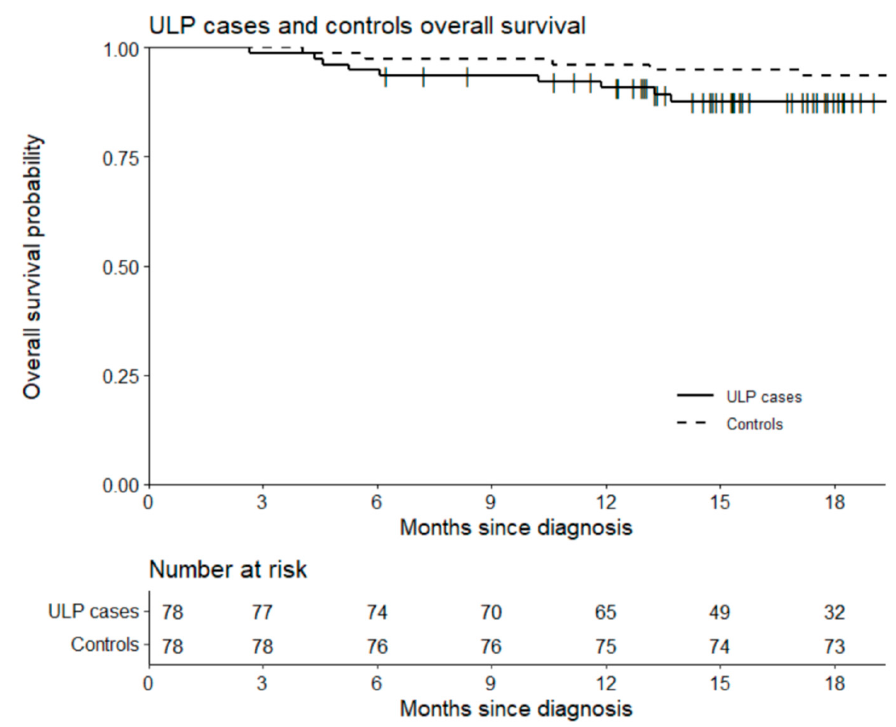
Figure 4. Overall survival of cases (including in ULP) and control groups.